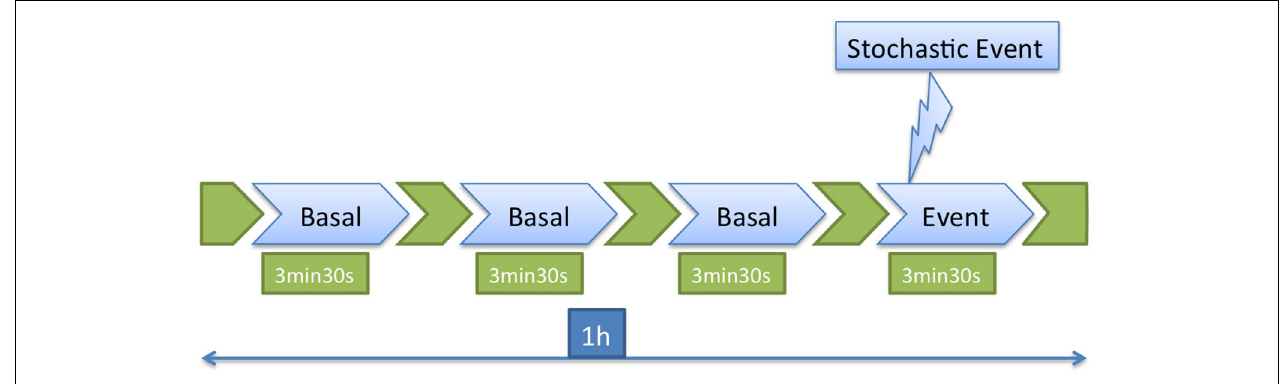
FIGURE 3 | Recording procedure. Three basal and one event response measurements were processed from the total recorded period of 1 h.